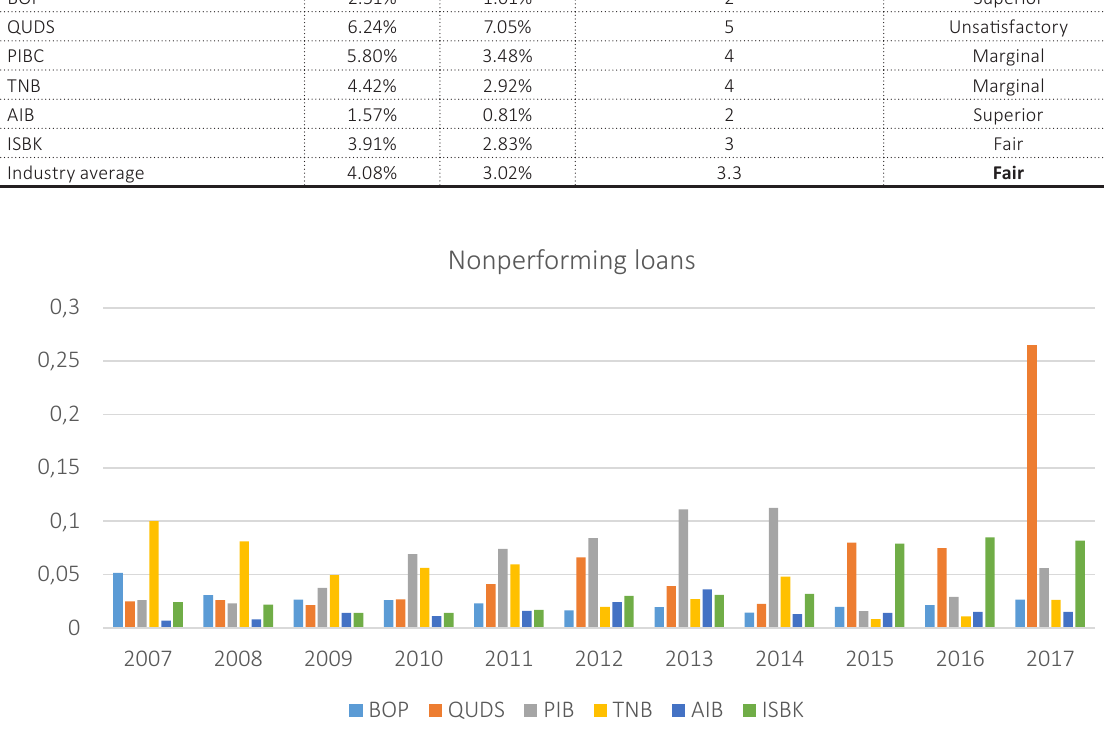
Figure 2. Nonperforming loans of listed banks (2007–2017)